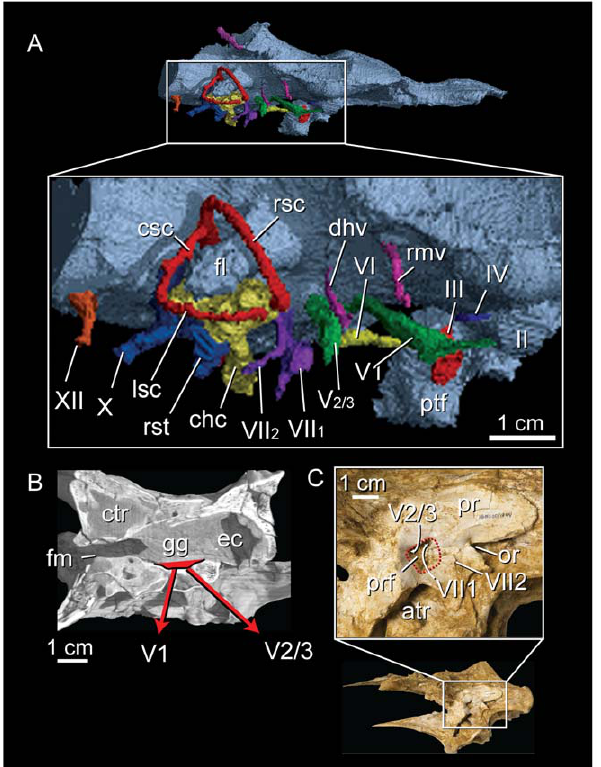
Figure 6. Morphology of the cranial nerve roots in Alioramus altai (IGM 100/1844). (A) Digital reconstruction of the cranial nerve roots in right dorsolateral view. (B) Horizontal CT slice showing the position of the gasserian ganglion and the split paths of the ophthalmic and maxillomandibular branches of the trigeminal nerve through the braincase. C) External view of the left lateral surface of the braincase showing the position of the prootic fossa, which accepts the lateral opening of the maxillomandibular branch of the trigeminal nerve and the palatine branch of the facial nerve. II, optic canal; III, oculomotor canal; IV, trochlear canal; V 1 , ophthalmic ramus of the trigeminal canal; V 2/3 , maxillomandibular ramus of the trigeminal canal; VI, abducens canal; VII 1 , palatine ramus of facial canal; VII 2 , hypoglossal ramus of facial canal; X, vagal canal; XII, hypoglossal canal; atr, anterior tympanic recess; chc, cochlear canal; csc, caudal semicircular canal; cts, caudal tympanic sinus; dhv, dorsal head vein canal; fl, floccular canal; fm, foramen magnum; gg, fossa housing gasserian ganglion; lsc, lateral semicircular canal; or, otic recess; ptf, pituitary fossa; rsc, rostral semicircular canal; rmv, rostral middle cerebral vein canal; rst, recessus scalae tympani.